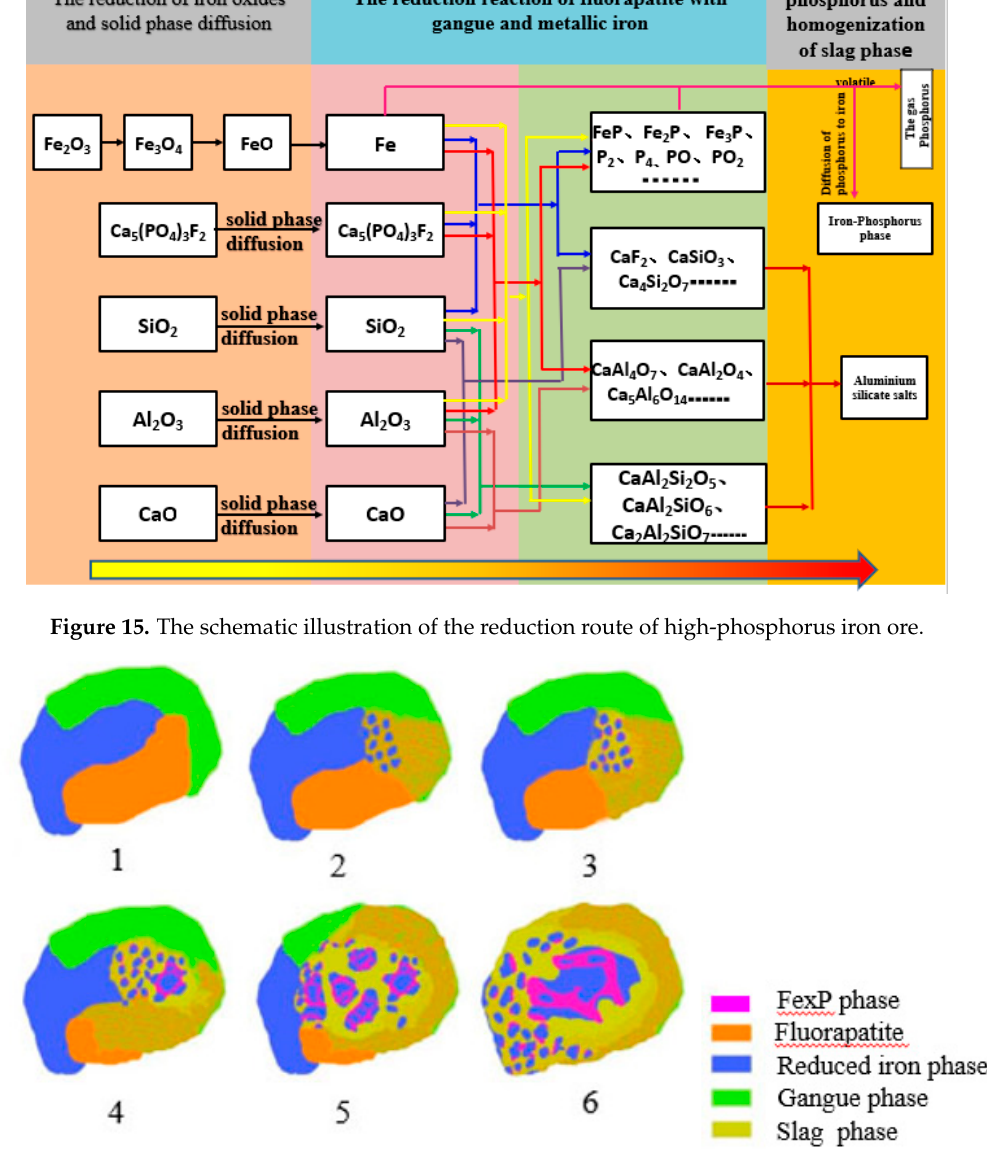
Figure 16. Diagram of the fluorapatite reduction process.